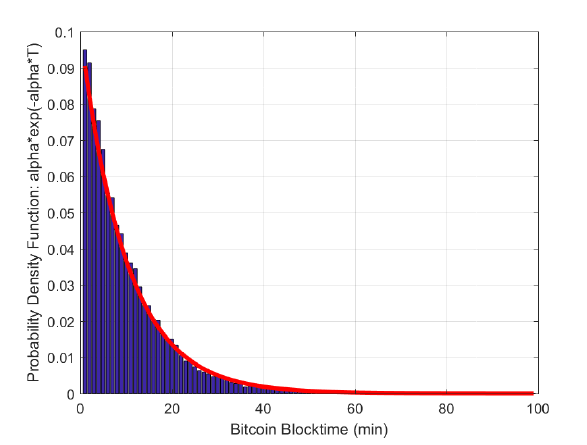
Figure 1: Theoretical probability density function (red) for the bitcoin blocktime compared against data in blocks 514,456-530,336 (blue).